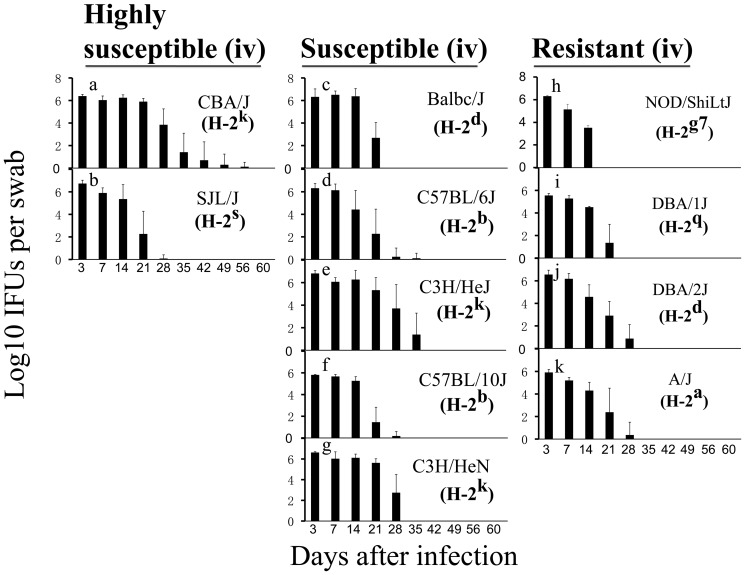
Live C. muridarum organism recovery from vaginal swabs along the infection time course.After the intravaginal infection (iv), the same eleven strains of mice described in Fig.1 legend were monitored for live chlamydial organism shedding from the lower genital tract. The number of live organisms recovered from the vagina/cervix swabs is expressed as log10 IFUs per swab and displayed along the Y-axis. The eleven strains of mice were classified into 3 distinct groups (panels a and b for highly susceptible, c–g for susceptible and h–k for resistant) as described in Fig. 1 legend. The H-2 haplotype of each mouse strain is also listed in the corresponding bar graph. Note that the susceptibility to hydrosalpinx induction did not correlate with either the level or duration of live organism shedding or the H-2 haplotypes.